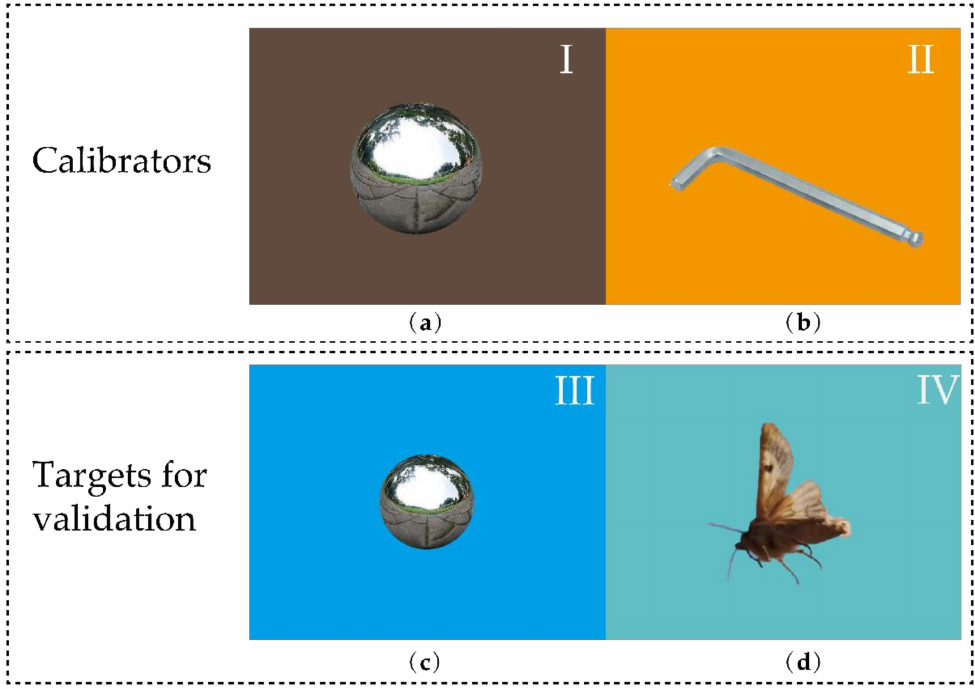
Figure 10. Calibrators and targets for validation. ( a ) Target I: sphere with 122mm diameters; ( b ) Target II: wrench with 120mm length; ( c ) Target III: sphere with 60mm diameters; ( d ) Target IV: bollworm with 15mm